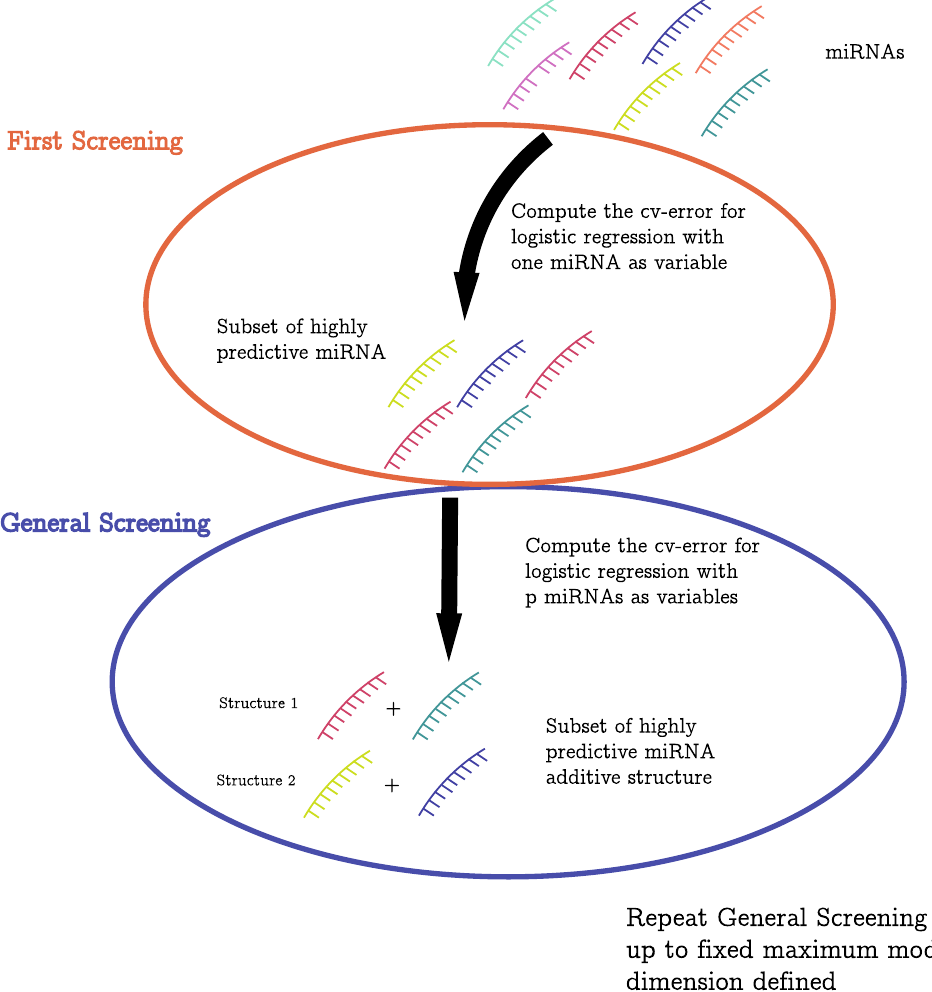
Figure 1. SWAG flowchart. A schematic representation of how the SWAG was calibrated for this work. The red set represents the first step which evaluates every one-dimensional model and selects the best expressions to be used in the general step represented by the blue set. The latter step evaluates and selects the best models of dimension 2 to p max